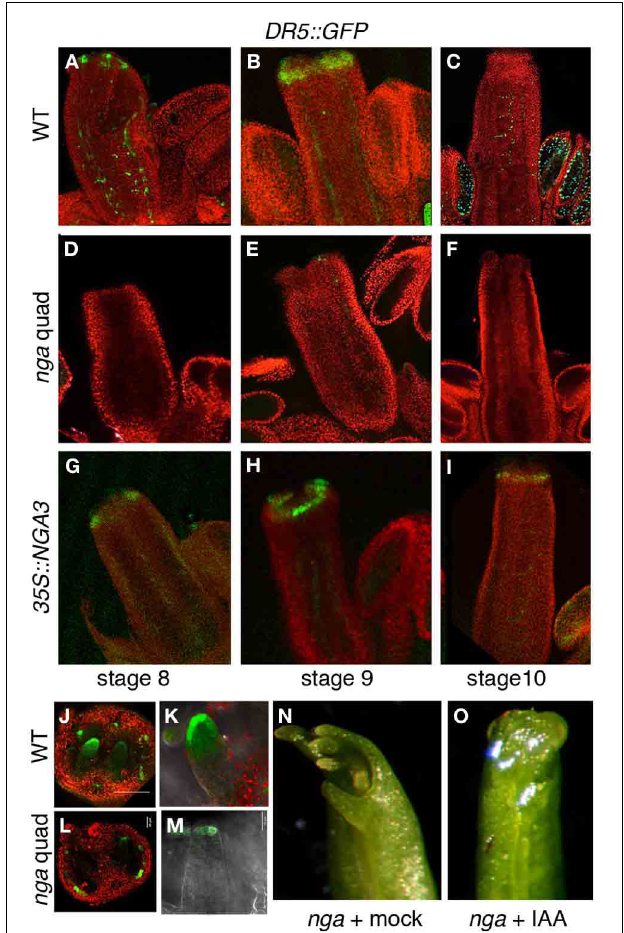
FIGURE 3 | Effect of NGA altered activity on DR5rev::GFP expression in gynoecium development. (A–C) DR5rev::GFP in wildtype